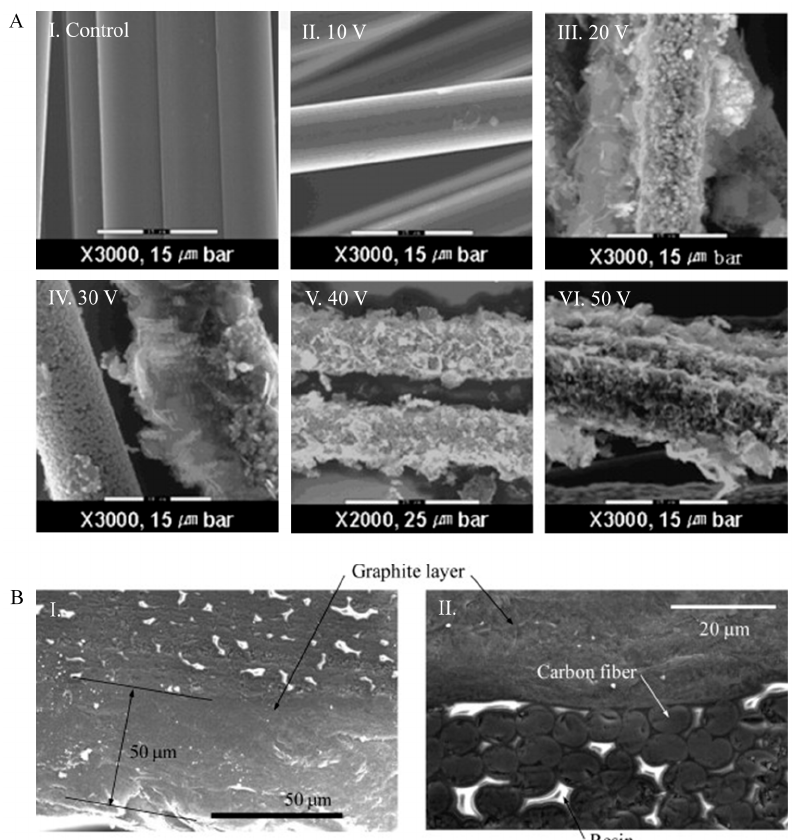
Figure 4. ( A ) SEM images for the surface of CFs at different applied voltages for 5 min. Reprinted with permission from ref. [112], Copyright 2008 Elsevier Ltd. ( B ) SEM images: I. composite plate coated with a 2- μ m-thick graphite layer; II. composite plate coated with a 50- μ m-thick graphite layer. Reprinted with permission from ref. [116], Copyright 2011 Else- vier